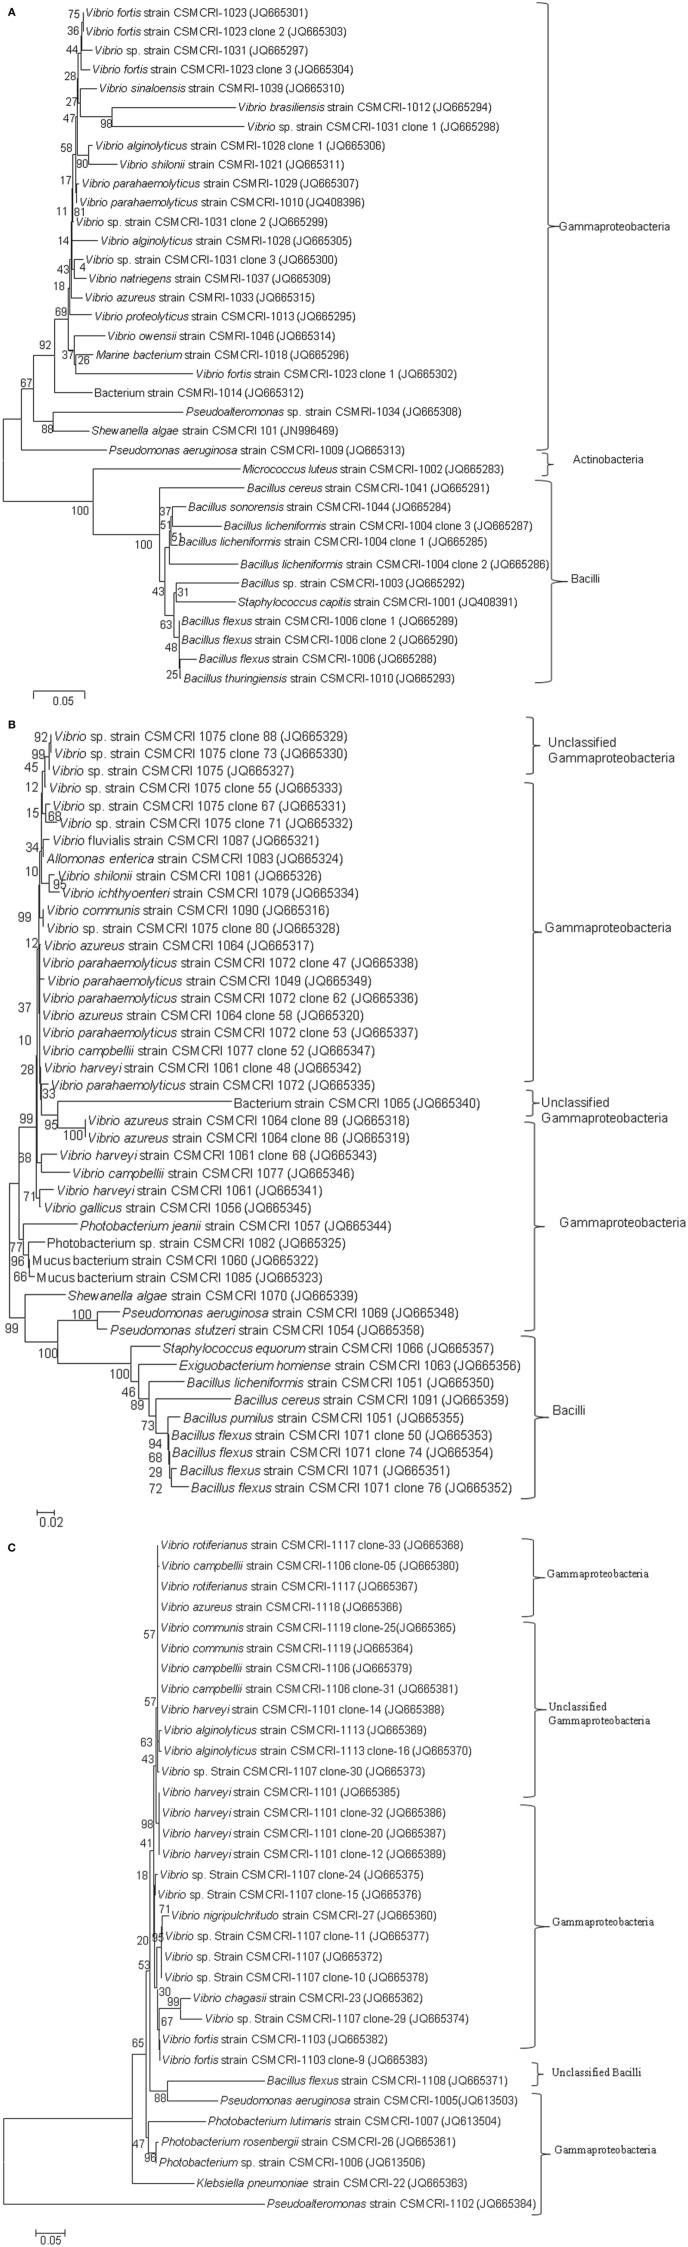
Phylogenetic relationships of bacterial communities isolated from Ulva and Gracilaria species during pre-monsoon (2A), monsoon (2B), and post-monsoon (2C) seasons in 2011. Neighbor-Joining method used for 16S rRNA analysis (Saitou and Nei, 1987). Bootstrap test was performed with 1000 replicates in the phylogenetic trees (Felsenstein, 1985). The tree is drawn to scale, with branch lengths in the same units as those of the evolutionary distances used to infer phylogenetic trees. The evolutionary distances were computed using the Kimura 2-parameter method (Kimura, 1980) and are in the units of the number of base substitutions per site. The rate variation among sites was modeled with a gamma distribution (shape parameter = 5 for pre-monsoon post-monsoon and 2 for monsoon season). Phylogenetic analyses were conducted in MEGA5 (Tamura et al., 2011).